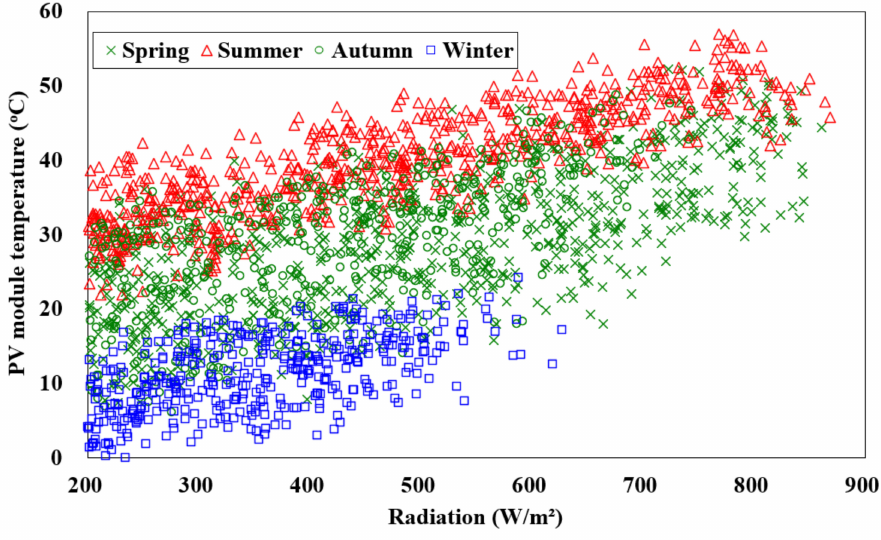
Figure 12. Annual PV module temperature with solar